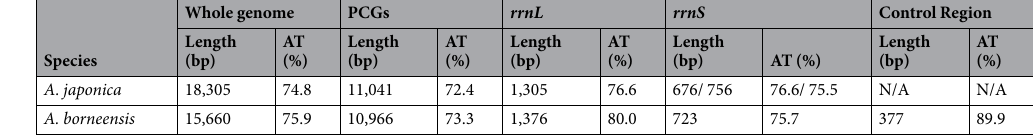
Table 1. Nucleotide composition in conserved regions of webspinner